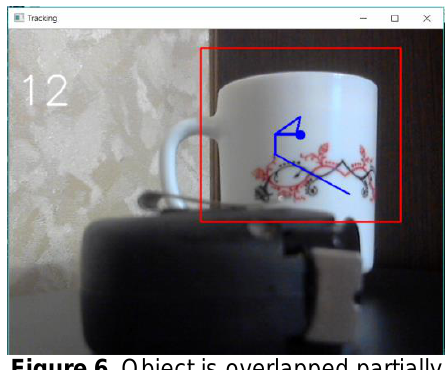
Figure 6 . Object is overlapped partially When the object is overlapped partially by the black block, the tracker often continues to track, but the detector sometimes cannot find the object. This is due to specific tuning of the detector YOLO for recognition many classes of objects. It recognizes black block as TV or monitor with high probability, which greater than probability of the target object. We plan to solve this problem in the future through additional tuning of the detector.